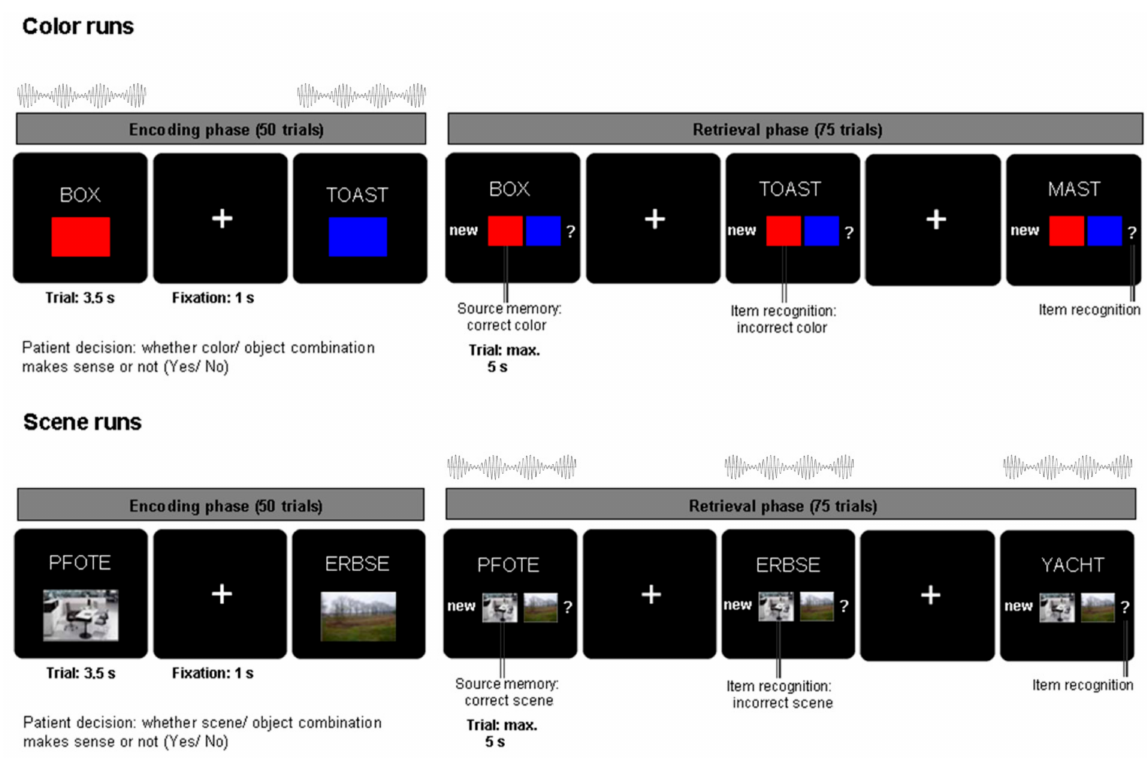
Figure 1. Experimental paradigm: Schematic depiction of the associative memory paradigm and the beat stimulation interventions (see